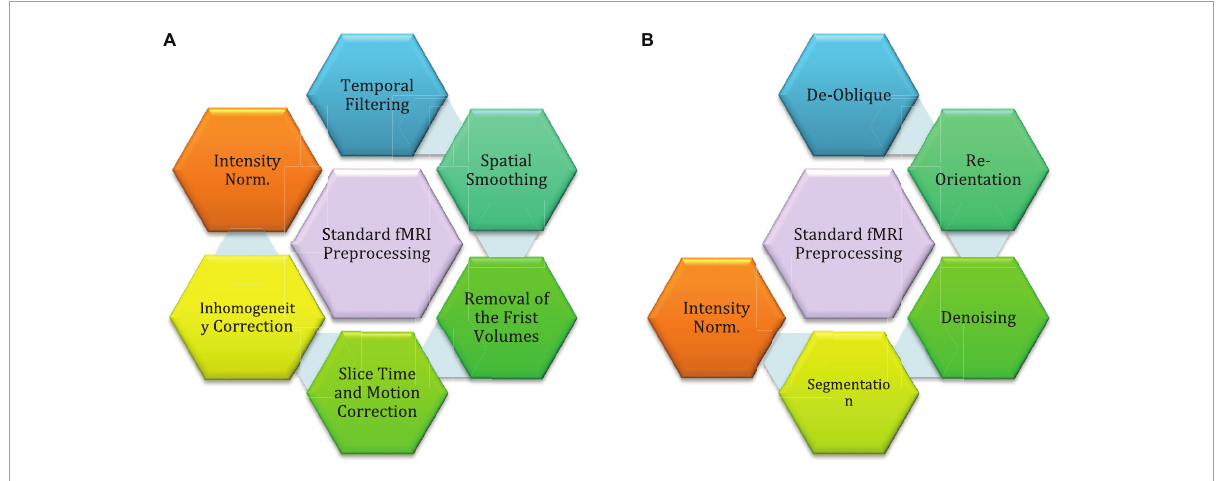
FIGURE3 Standard preprocessing methods for MRI neuroimaging modalities: (A) preprocessing for fMRI data, (B) preprocessing for sMRI